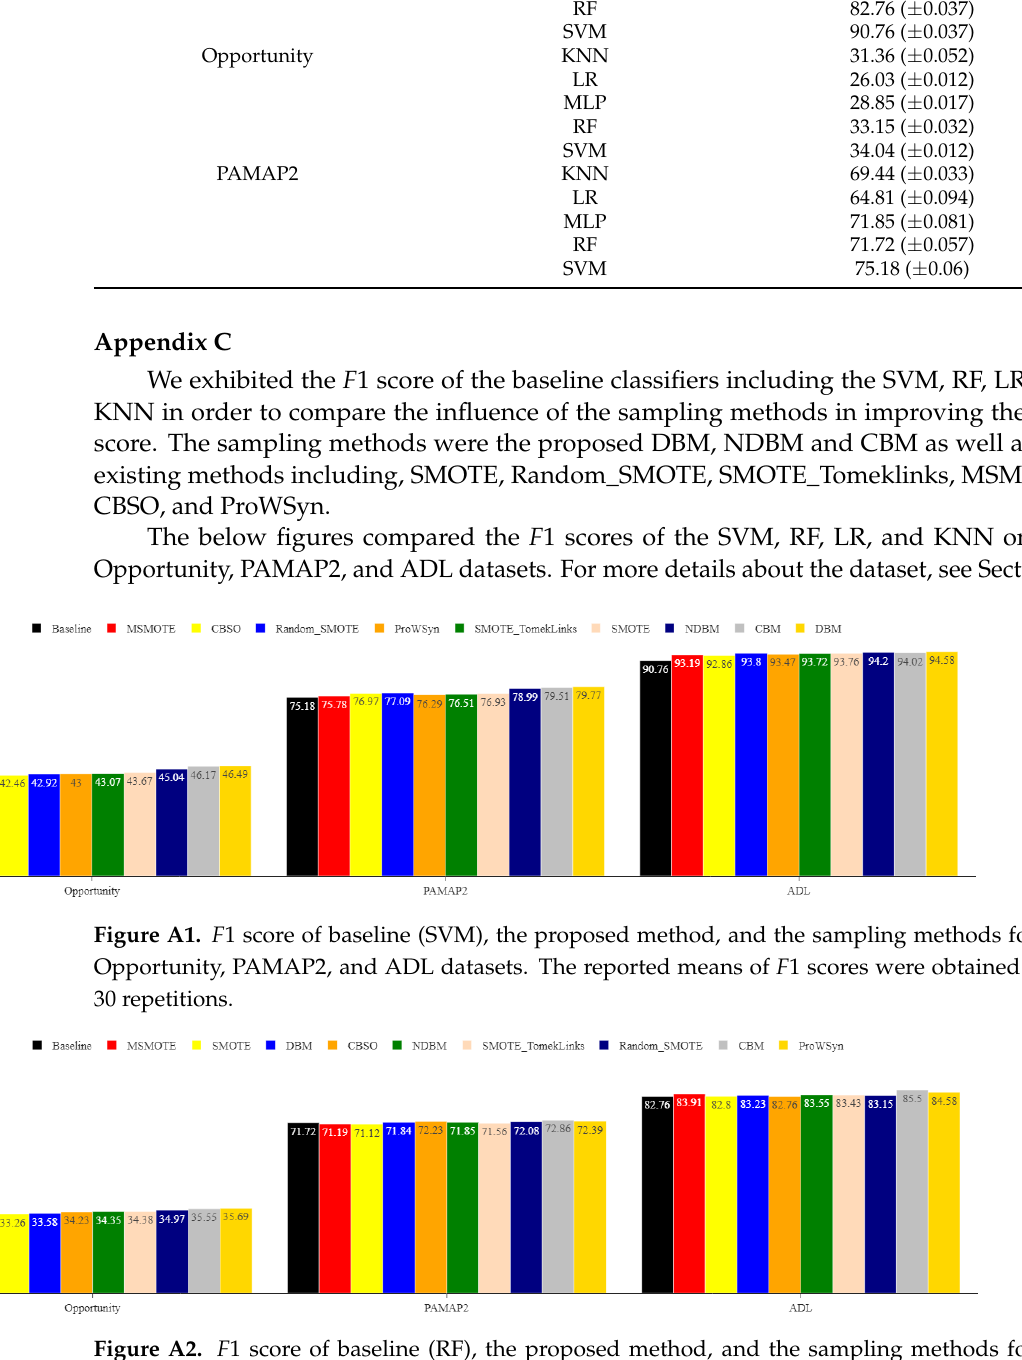
Figure A2. F 1 score of baseline (RF), the proposed method, and the sampling methods for the Opportunity, PAMAP2, and ADL datasets. The reported means of F 1 scores were obtained from 30